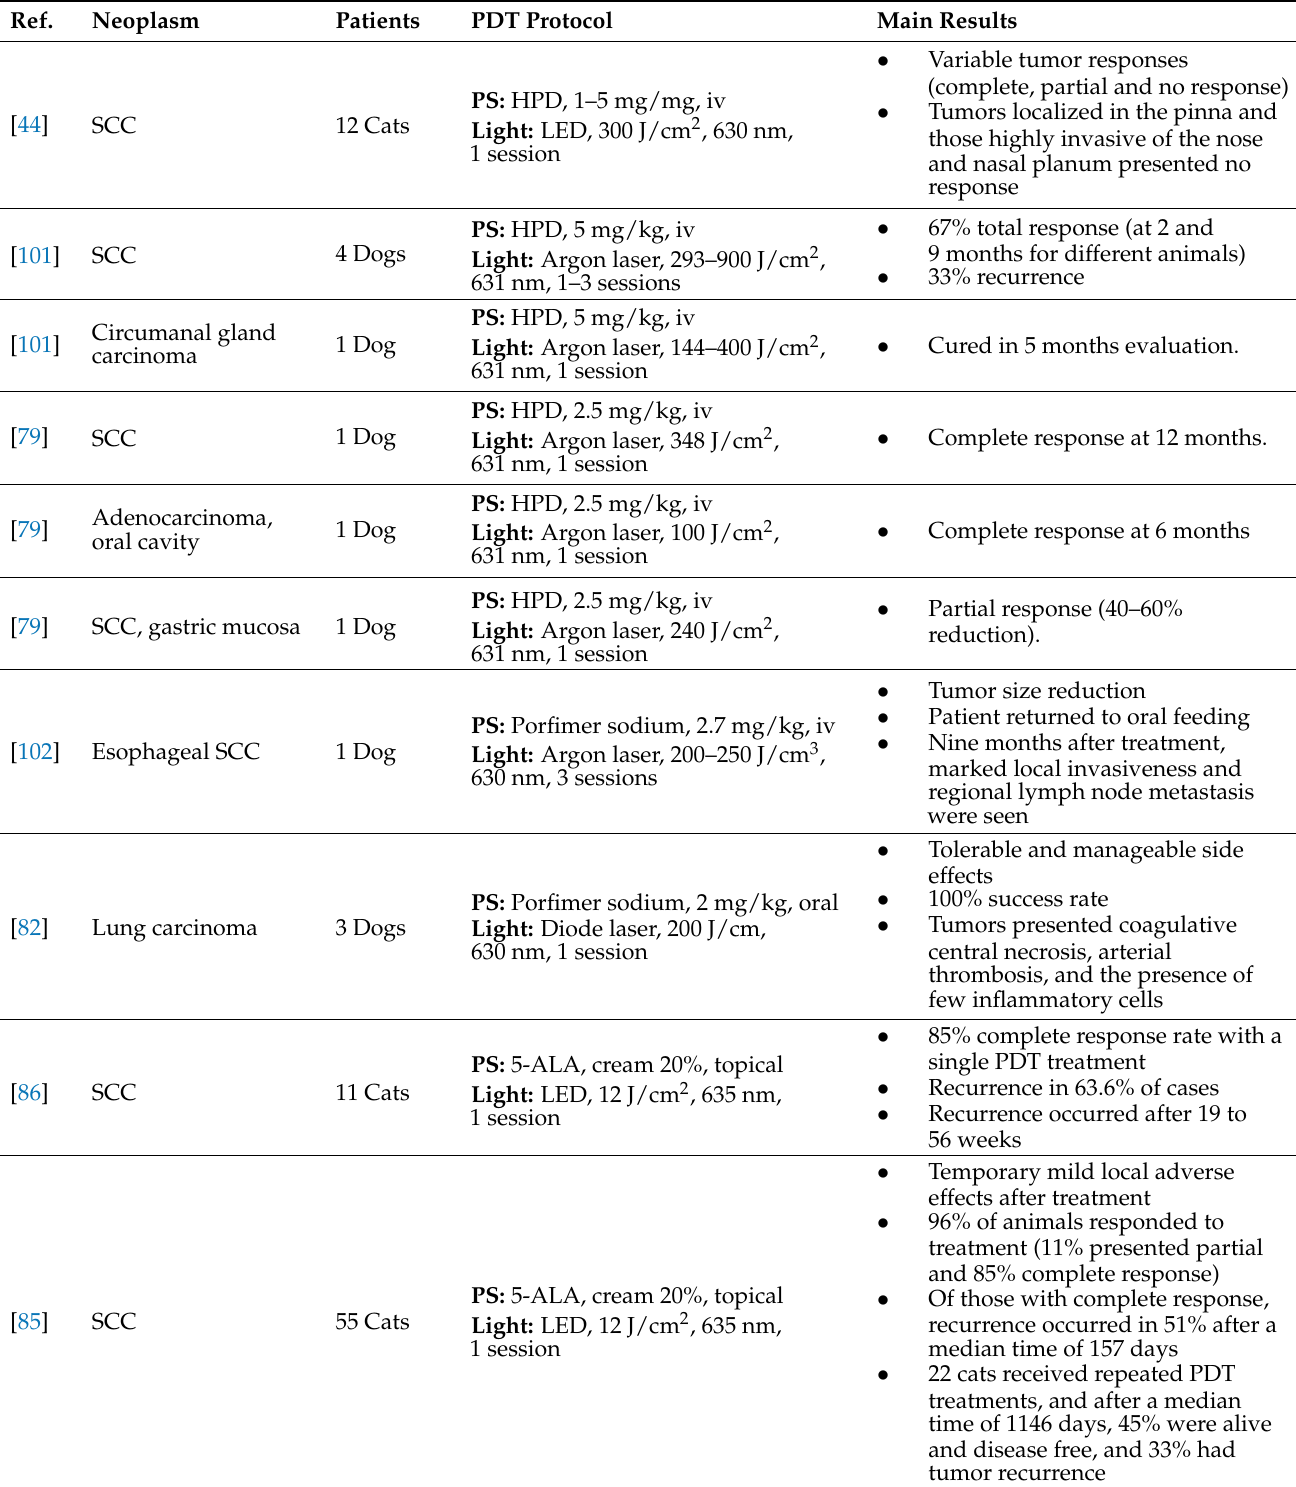
Table 1. Clinical studies on PDT in animals with